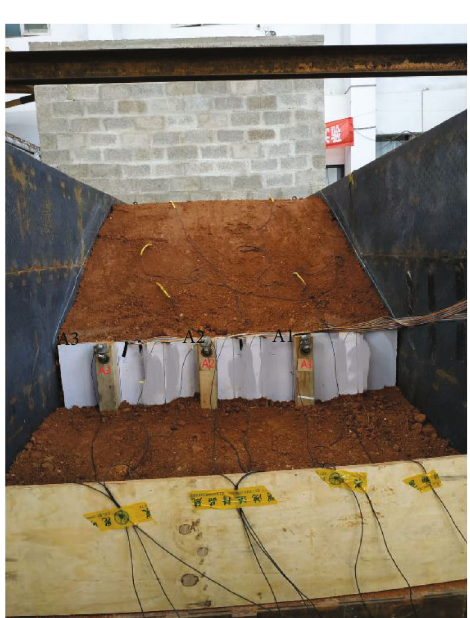
Figure 3: Assembly of the acceleration sensors.